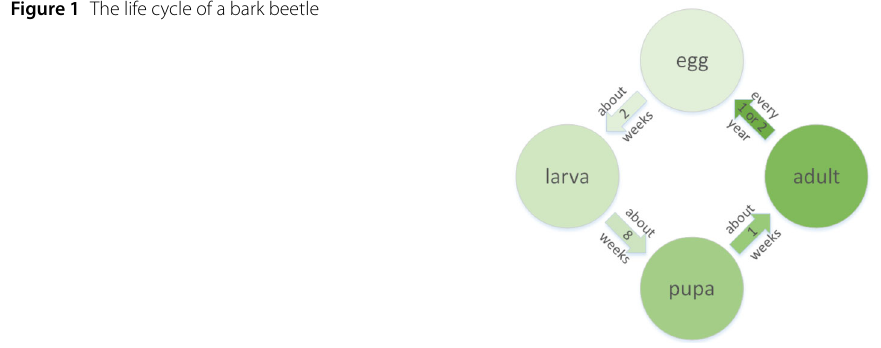
Figure 1 The life cycle of a bark